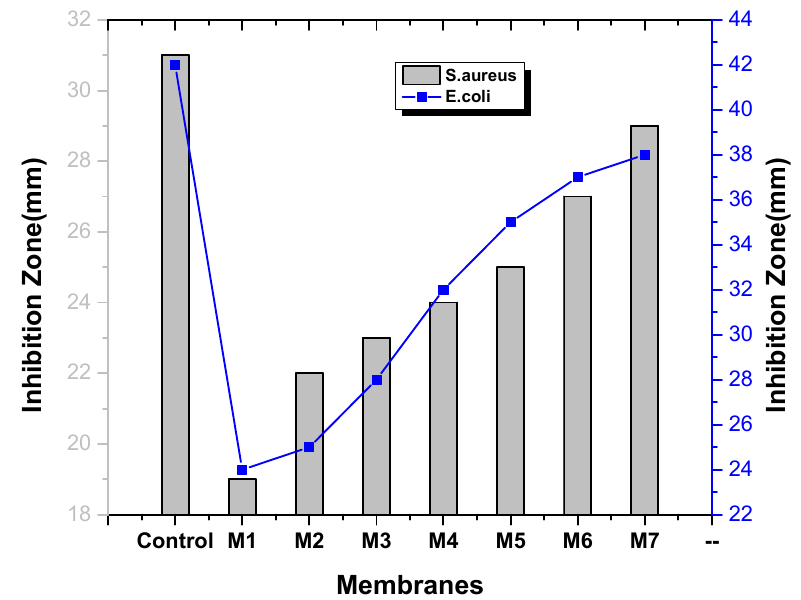
Figure 11. Anti-bacterial activity of nanocomposite Figure 11. Anti ‐ bacterial activity of nanocomposite membranes.